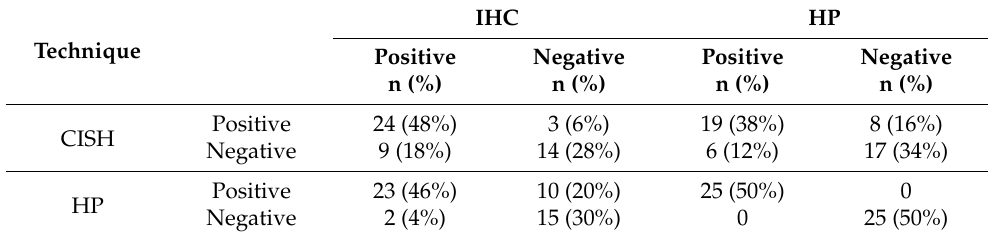
Table 3. Comparison of the number of positive and negative cases for amastigotes obtained using CISH, IHC, and HP in samples fixed in 10% formalin and paraffin-embedded of cutaneous lesions from patients with new world cutaneous leishmaniasis caused by L. ( V. ) braziliensis